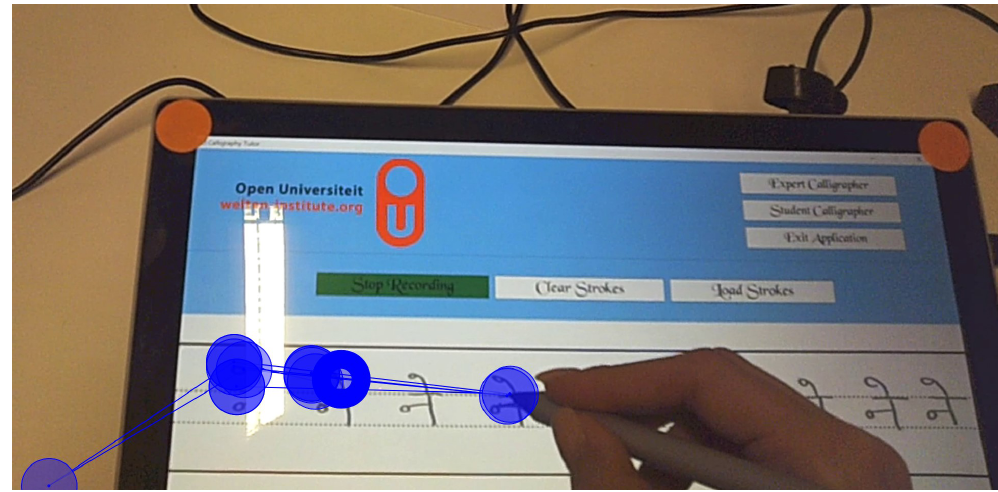
Figure 10. Visual scan path of the participant while